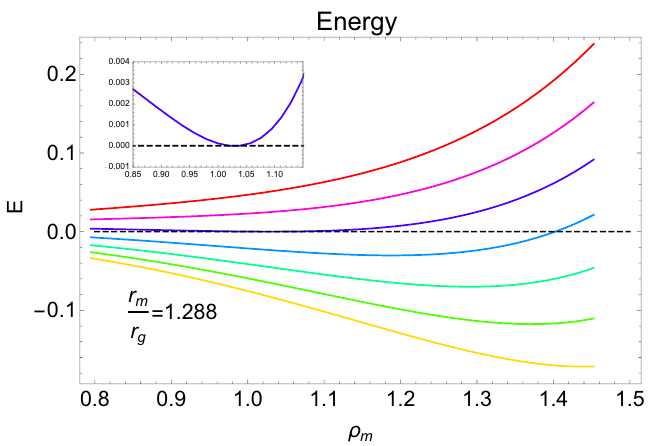
Figure 5 . The black dotted line is a visual representation of the energy of the straight brane (it should be a point at ρ = 0 ) while each colored line represents all brane configurations ending on m the r surface. Different colors are shown for different quark masses (with yellow being the smallest m and red being the